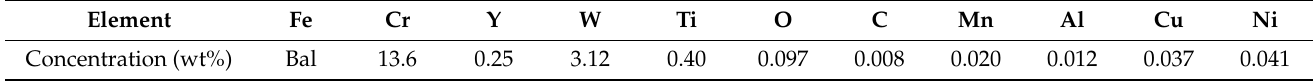
Table 1. Composition of the NFA 14YWT FCRD-NFA1 [64]. Element Fe Cr Concentration